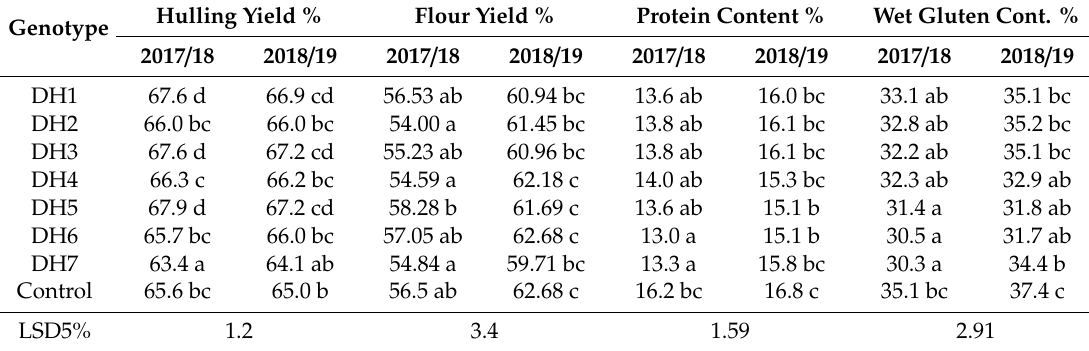
Table 11. Processing e ffi ciency and some selected chemical parameters of ‘Tonkoly.pop1’ spelt wheat advanced line (Control) and its doubled haploid (DH) lines based on field experiment in two consecutive years. Values with the same capital letters are not significantly di ff erent ( p > 0.05).